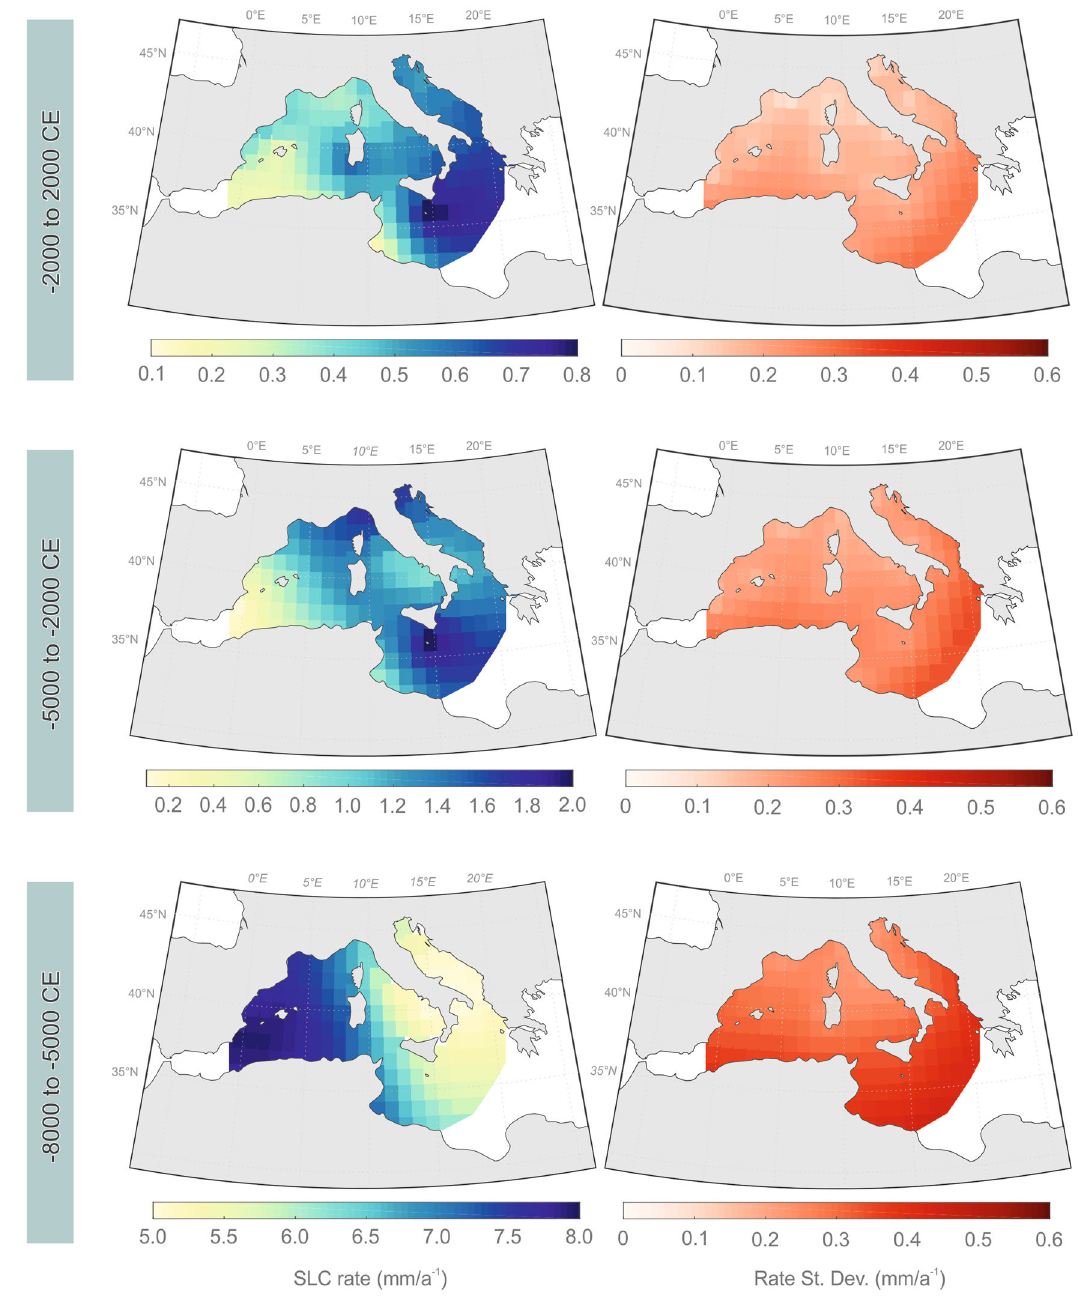
Fig. 3 Spatial and temporal variability of relative sea-level (RSL) changes and their uncertainties across the central and western Mediterranean basin in the time periods 2000 to − 2000 CE, − 2000 to − 5000 CE, and − 5000 to − 8000 CE. Note the changes of scale for the different time